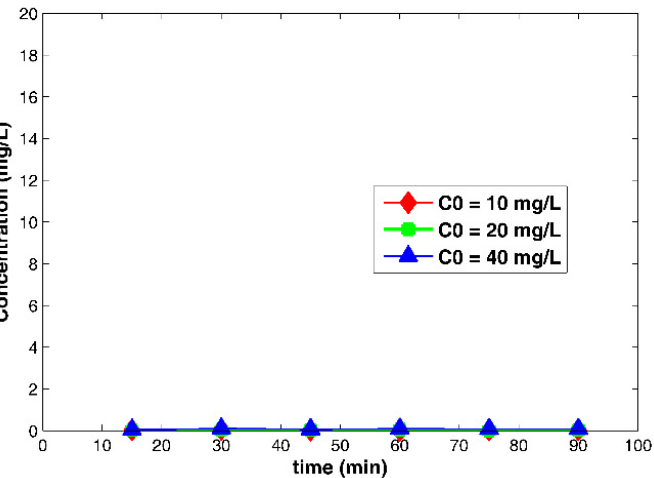
Figure 9. Effect of initial concentration on elimination of Congo Red by filtration using photocat- alytic membrane.